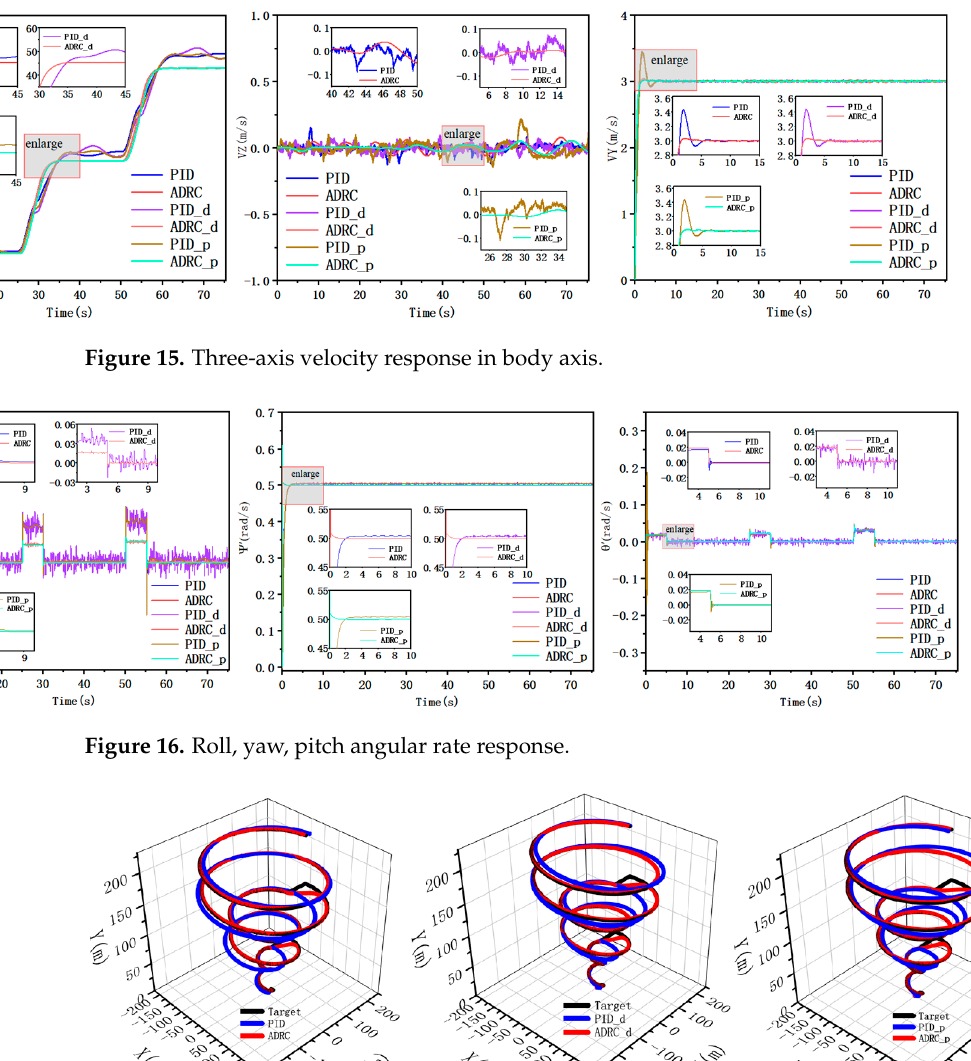
Figure 14. Three-axis trajectory tracking response and error.